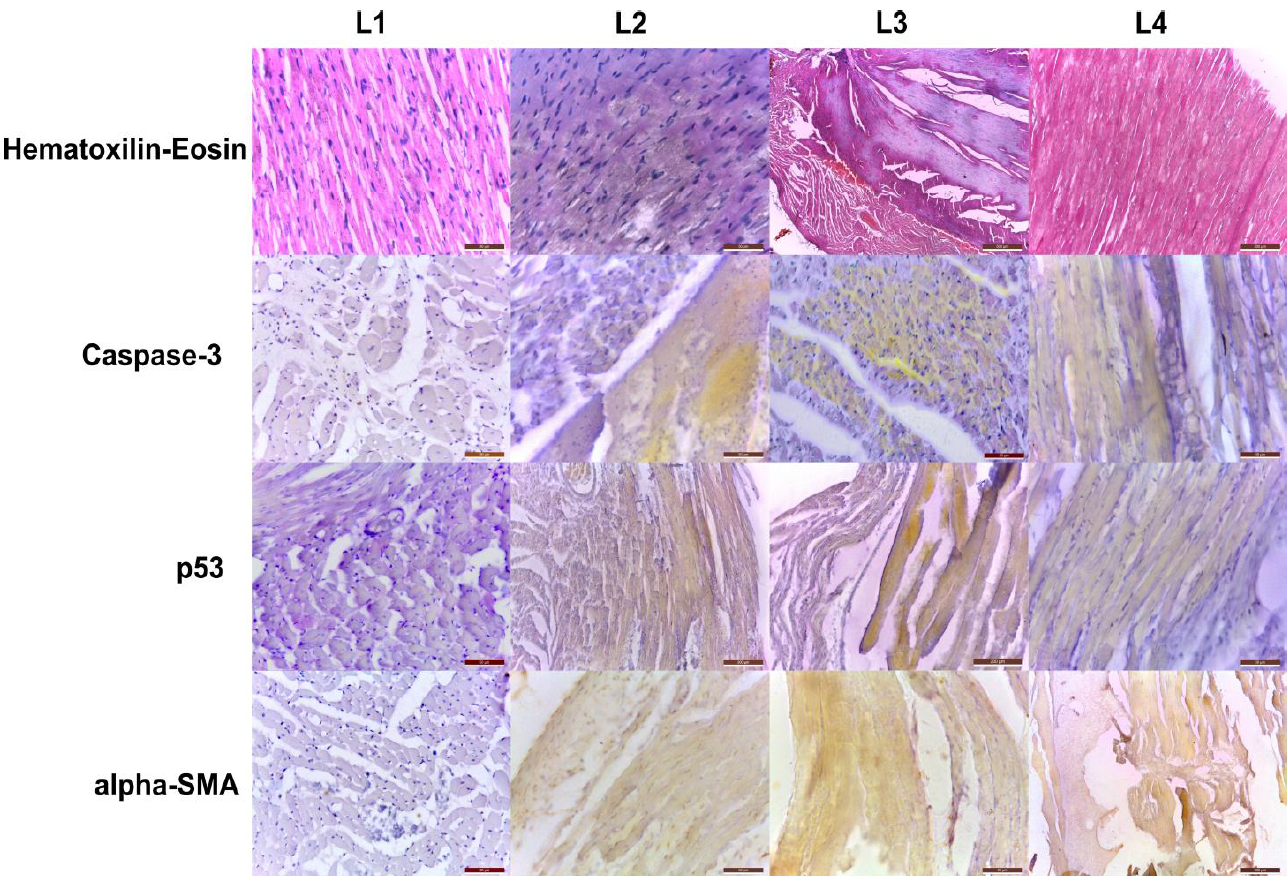
Figure 3. Cardiac histopathology, with representative slides for each group, demonstrates progressive lesions with focal necrosis, disorganization of myofibrils and intracytoplasmic vacuolization with close matching of immunohistochemistry markers of genotoxicity, apoptosis, and fibrosis (left panels, scale bar = 20-50-50-50 μm, middle panels, scale bar = 50-50-200-50 μm and 500-50-200-50 μm and right panels, scale bar = 200-50-50-500 μm; 10-20-100× magnification).